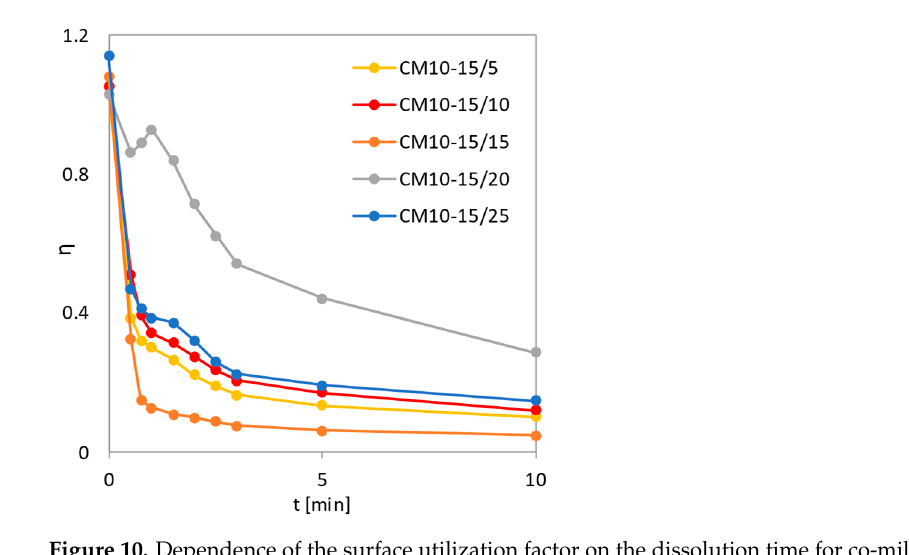
Figure 10. Dependence of the surface utilization factor on the dissolution time for co-milled mixtures with 10 mm balls with 15 wt.% SLS content. The co-milling time was 5, 10, 15, 20, and 25 min.